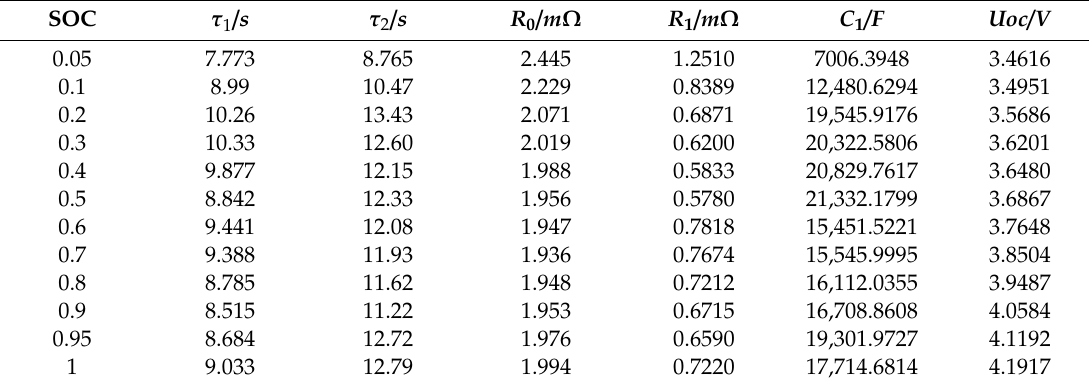
Table 1. Model parameters under di ff erent SOC